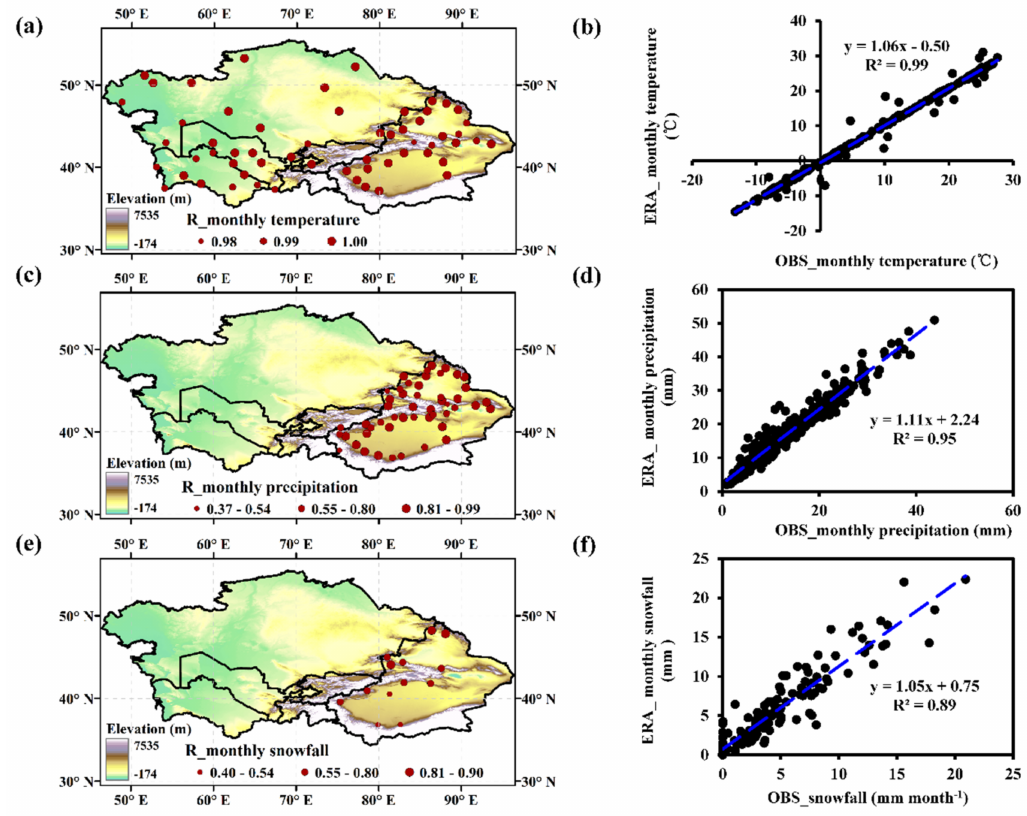
Figure 2. Determined coefficient (R 2 ) between ERA reanalysis data time series and the observed ones for monthly temperature ( a , b ), precipitation ( c , d ), and snowfall ( e , f ). ( b , d , f ) represent the averaged climatic variables of all